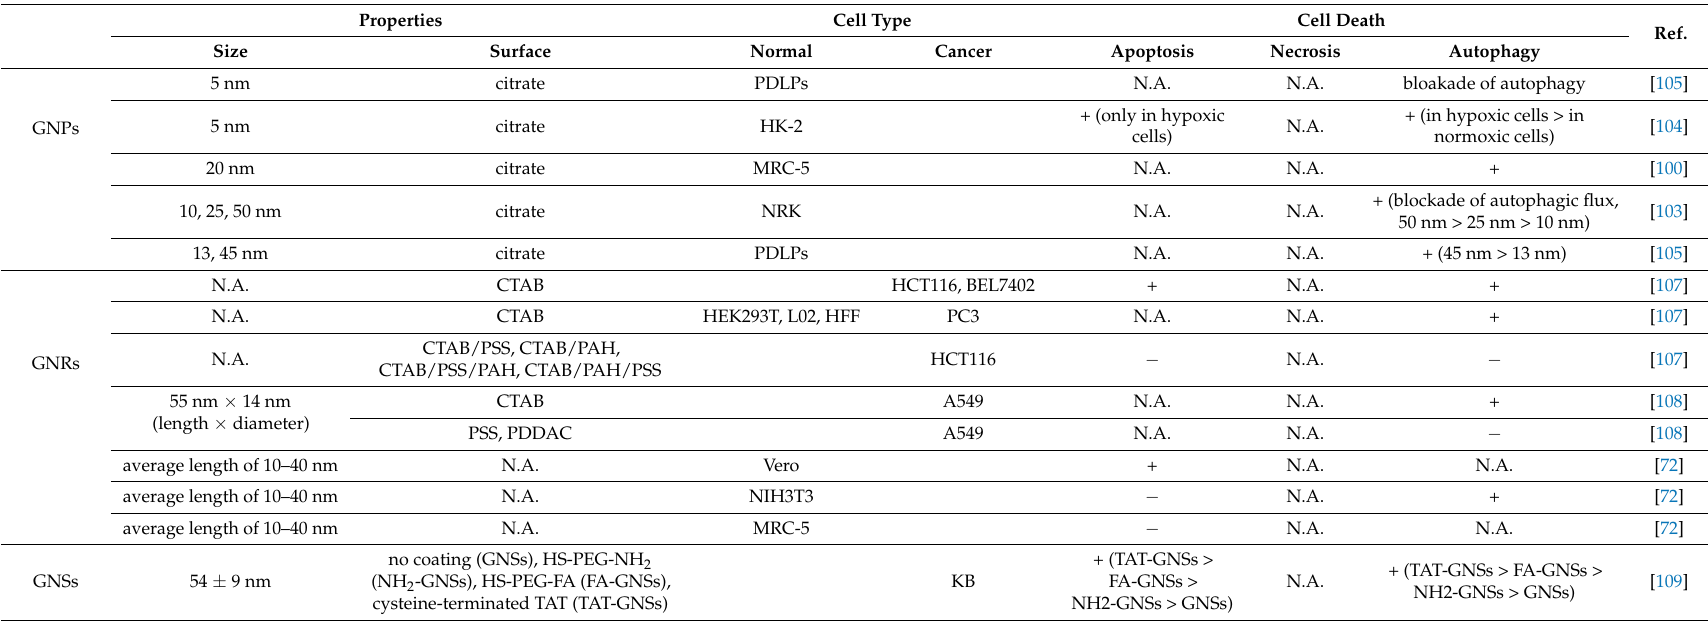
Table 3. The relationship between GNPs’ properties and